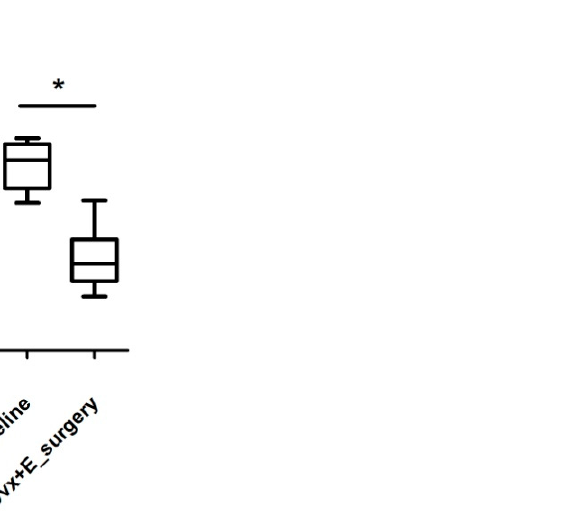
Ultrasound Appendix A Table A1. Differences after Ovariectomy and Estradiol Substitution in Cardiovascular Parameters in Hereditary Hypertriglyceridemic Rats. Sham n = 5